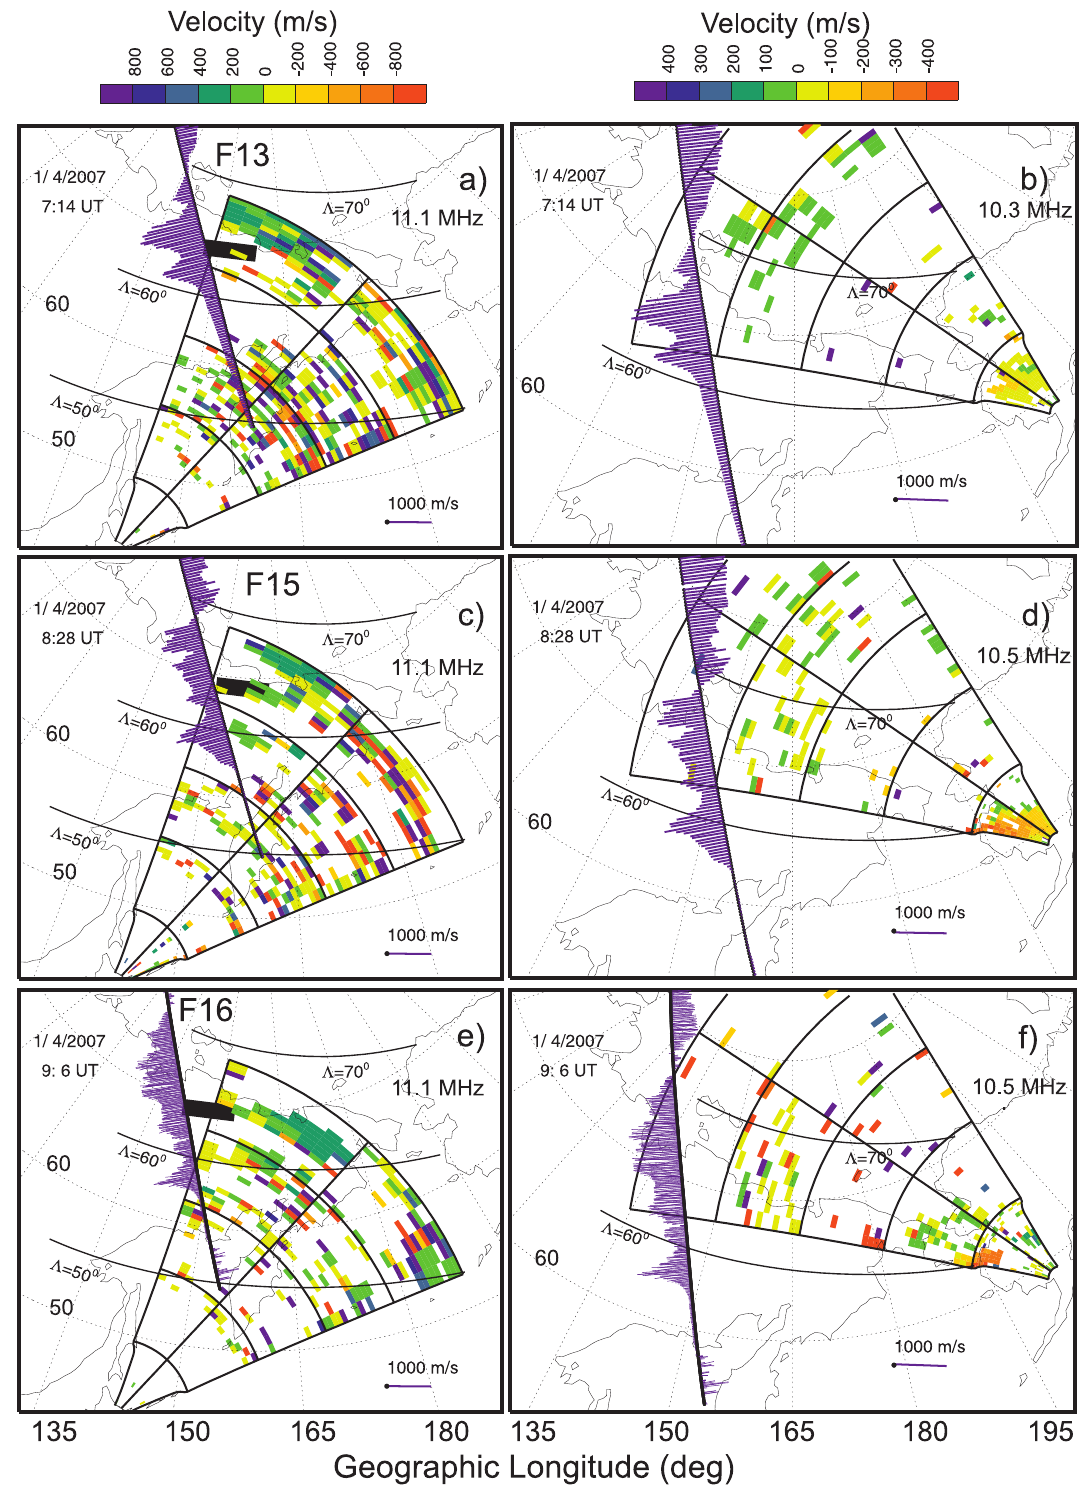
Fig. 4. SuperDARN velocity maps for the Hokkaido (left column) and King Salmon (right column) radars on 1 April 2007 and cross-track ion drift measured concurrently by the DMSP satellites. The black marker indicates an approximate position of the equatorial edge of the auroral